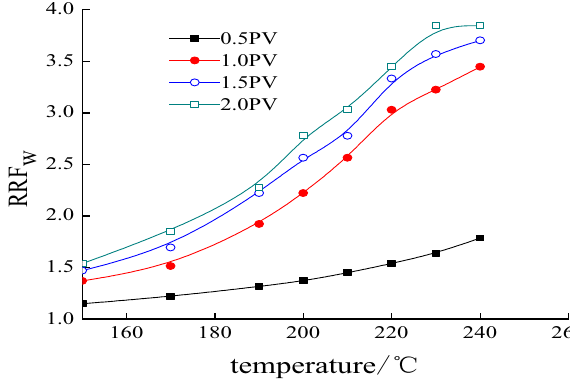
Fig. 5 The relationship between temperature and RRF